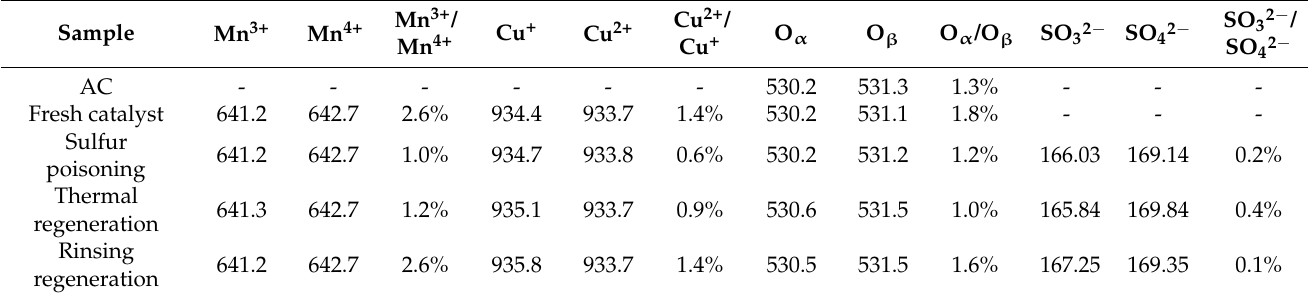
Table 2. XPS characterization results and surface element